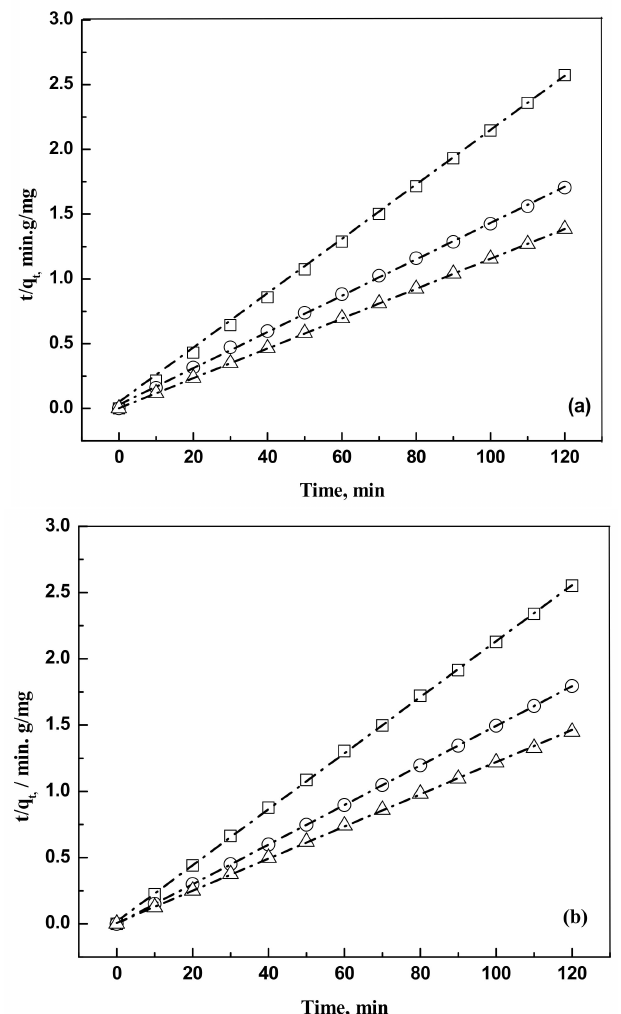
Figure 4. ( a ) Plot of pseudo second order kinetic modeling for the removal of eosin Y dye on activated carbon for an adsorbent dose of 0.5 g and a solution volume of 5 × 10 − 4 m 3 . Temperature, 303 K. Concentration: (cid:3) , 50 mg / L; , 75 mg / L; and ∆ , 100 mg / L. The dash dot lines are model predictions (cid:35) at the respective concentrations. ( b ) Plot of pseudo second order kinetic modeling for the removal of indigo carmine dye on activated carbon for an adsorbent dose of 0.5 g and a solution volume of 5 × 10 − 4 m 3 . Temperature, 303 K. Concentration: (cid:3) , 50 mg / L; , 75 mg / L; and ∆ , 100 mg / L. The dash (cid:35) dot lines are model predictions at the respective